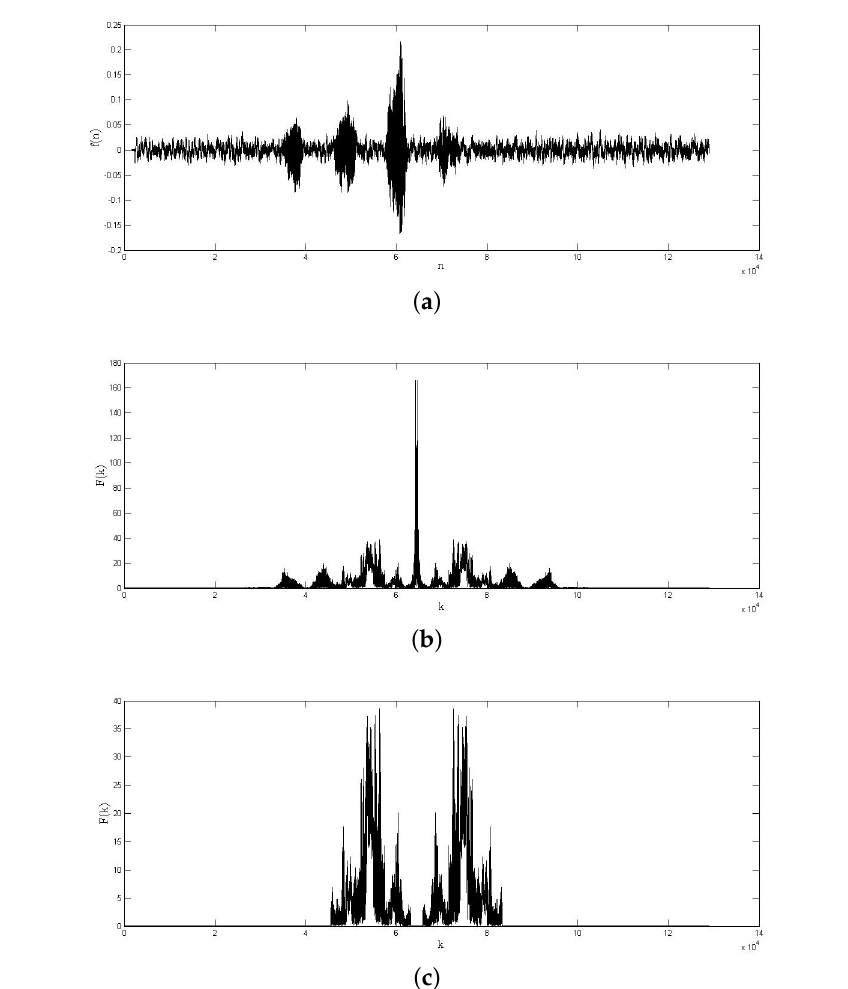
Figure 6. Example of a frequency region of interest extraction: ( a ) audio record from a bird vocalization; ( b ) 1D DFT of the bird vocalization; and ( c ) frequency region of interest